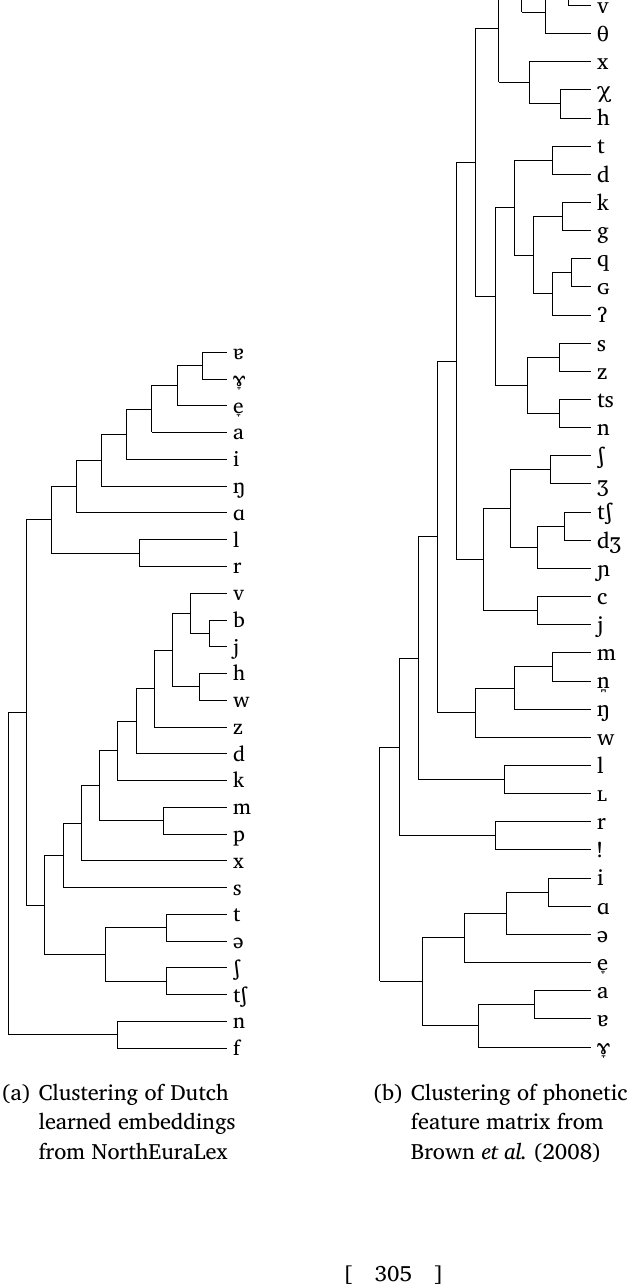
Figure 2: Hierarchical clusterings, using euclidean distance and neighbour joining, of NorthEuralex learned phoneme embedding for Dutch and the phonetic feature matrix from Brown et al.